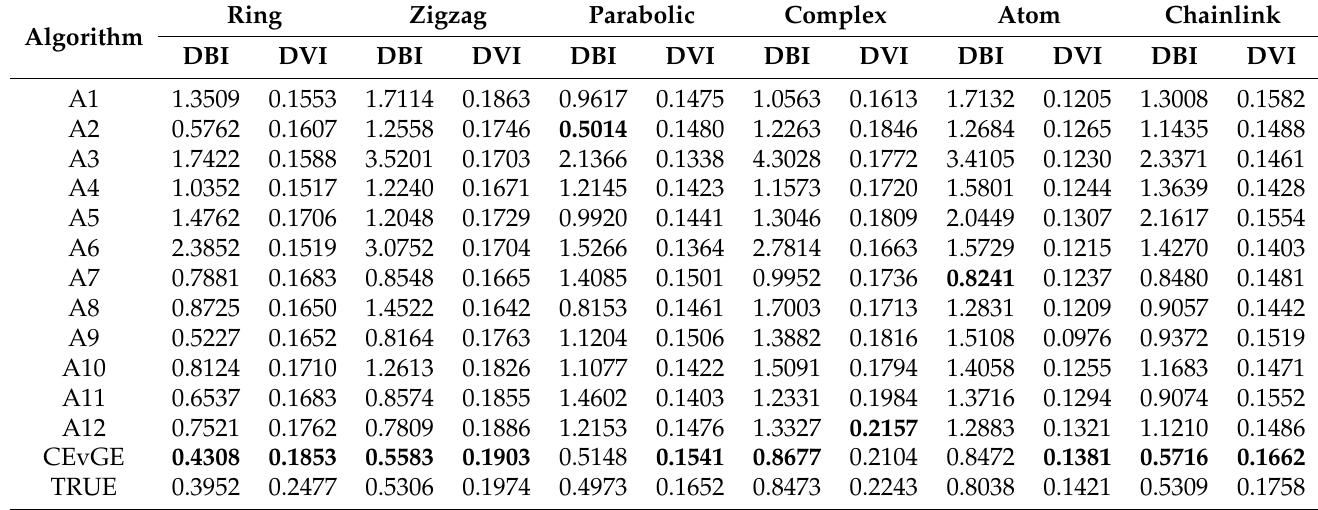
Table 4. Internal indexes of different algorithms on synthetic data sets.